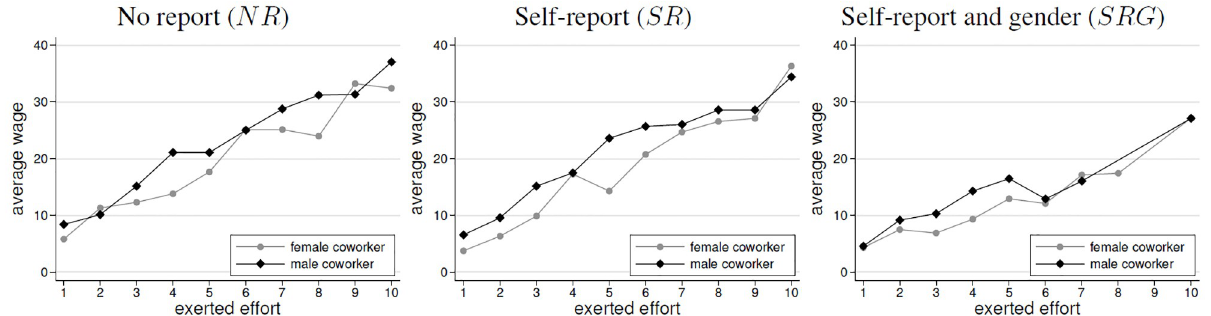
Fig 6. Wage-effort relations by co-worker’s gender. Only data points with at least ten underlying observations are shown.